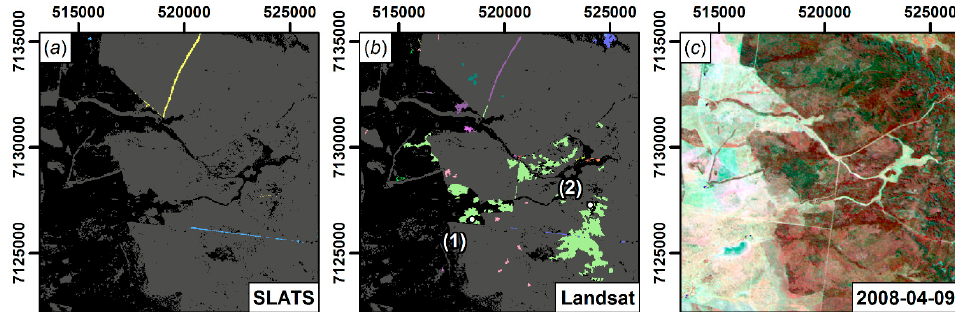
Figure 8. Cont. Figure 8.